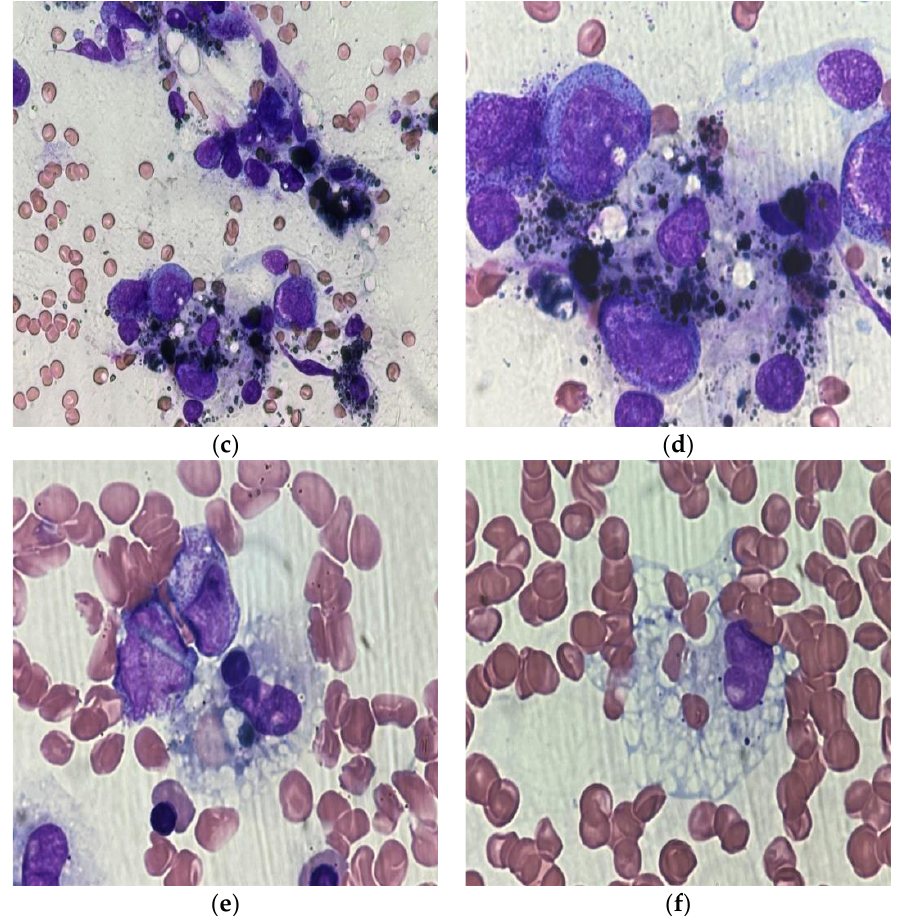
Figure 3. Hemophagocytic lymphohistiocytosis ( a – f ) (HLH) in patient with plasma cell myeloma. Bone marrow aspirate smear depicting hemophagocytosis, macrophages engulfing erythrocytes and erythroblasts (different magnitudes).